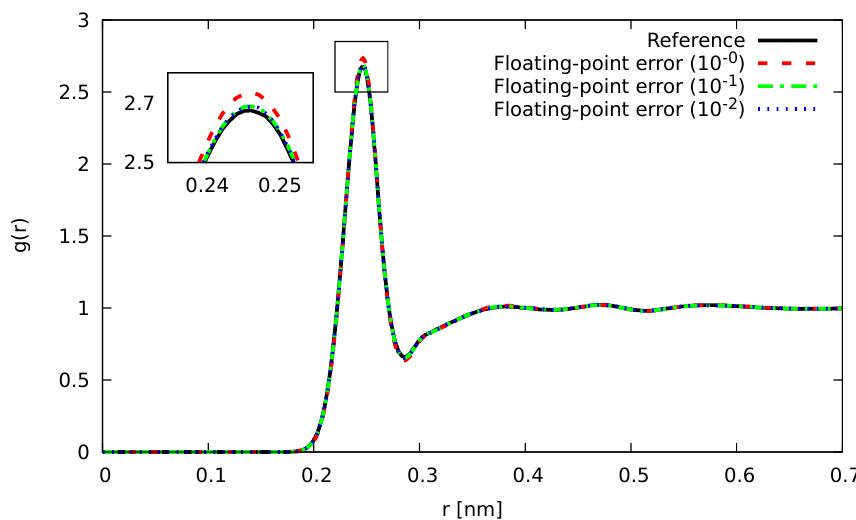
Figure 2. Partial pair correlation function for liquid Si at 3000 K with noisy forces introduced by floating-point errors of magnitude 10 − 2 (blue), 10 − 1 (green), and 10 − 0 (red). For comparison, the results, as obtained by our reference calculations without noise, are shown in black.